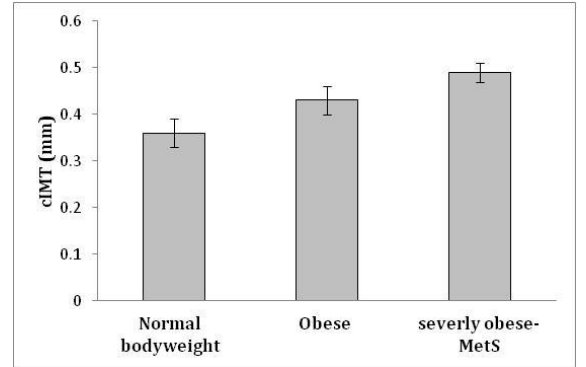
Figure 1: Mean and SEM of carotid intima-media thickness (cIMT) levels in the groups with normal bodyweight, obese without metabolic syndrome (MetS) and severely obese with MetS.